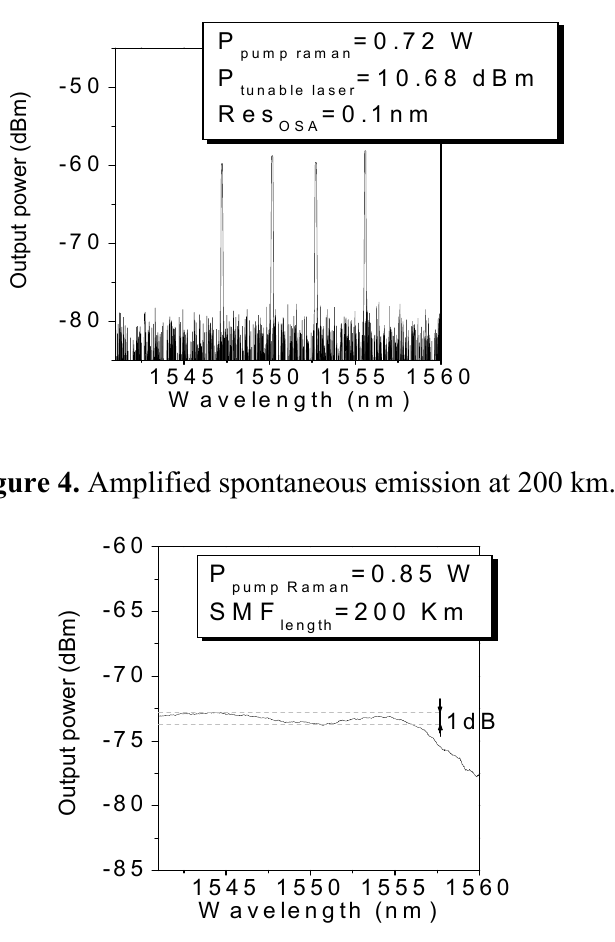
Figure 3. Spectrum of the reflected signal from the four remotely multiplexed FBGs.